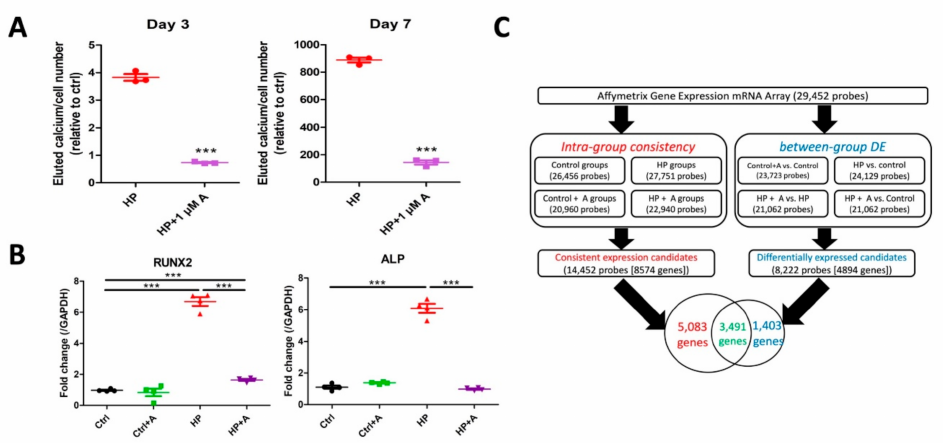
Figure 2. Microarray experiments and the bioinformatic workflow. ( A ) Quantitation of calcification in cells subjected to HP and HP + astaxanthin at day 3 (left) and 7 (right). ( B ) Osteoblastic di ff erentiation genes’ (left, RUNX2; right, alkaline phosphatase (ALP)) expression levels in cells undergoing di ff erent treatments. ( C ) The algorithm of sequentially analyzing transcriptomic data generated from A ff ymetrix microarray experiments. *** p < 0.001 compared with the reference group; A, astaxanthin; Ctrl, control; DE, di ff erential expression; HP, high phosphate.